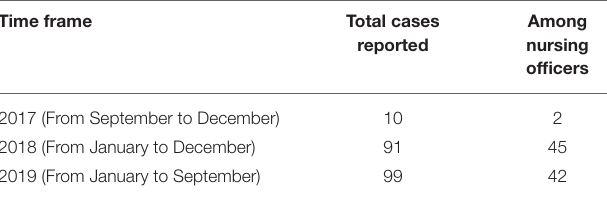
TABLE 3 | Needlestick injury including blood and body exposure cases reported at the institute from 2017 to 2019. Time